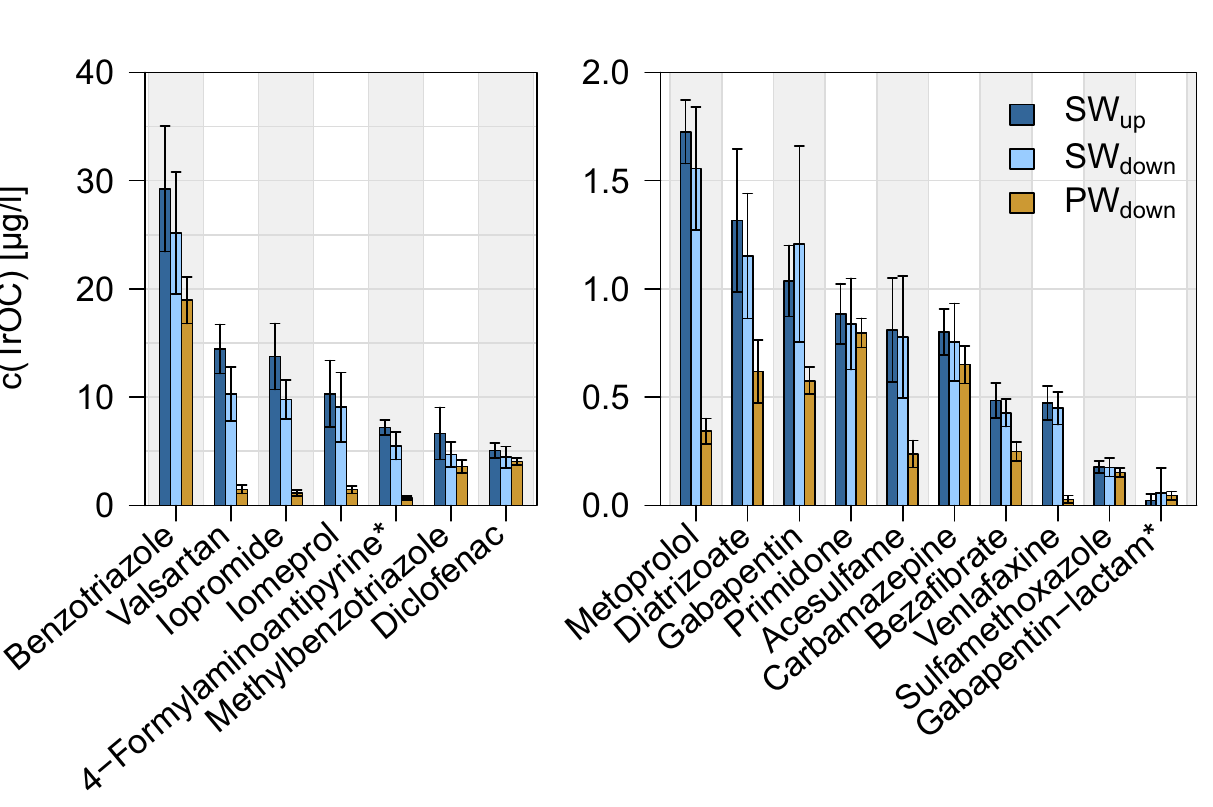
Figure 2. Mean TrOC concentrations at the upstream surface water sampling site (SW up ), the downstream surface water sampling site (SW down ) and the downstream pore water sampling site (PW down , in 25 sediment depth) (n = 17 (15 for SW up) , every 3 h over 48 h) . Graph split in two concentration ranges (right and left panel). Error bars indicate the standard deviation, * indicates transformation